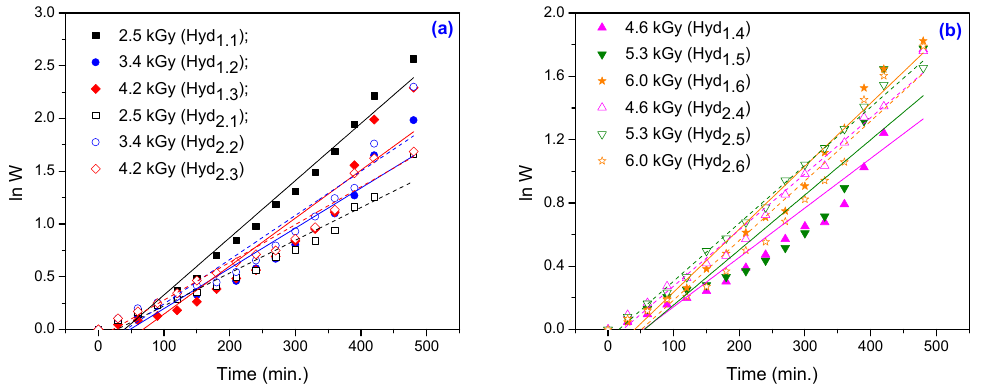
Figure 5. The first-order swelling kinetics for hydrogels obtained at: ( a ) 2.5 kGy, 3.4 kGy and 4.2 kGy; ( b ) 4.6 kGy, 5.3 kGy and 6.0 kGy.